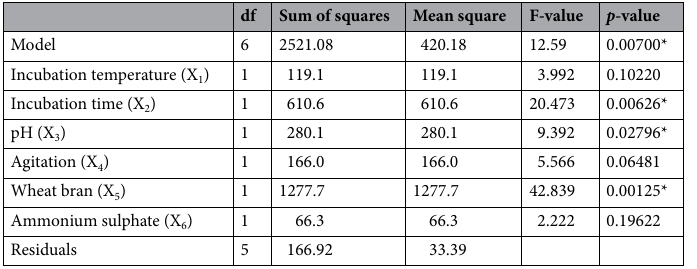
Table 5. Analysis of variance (ANOVA) for six variables by PBD experiment. df degree of freedom. *Significant p -value at p ≤ 0.05. Adjusted R 2 (mean coefficient of determination) =